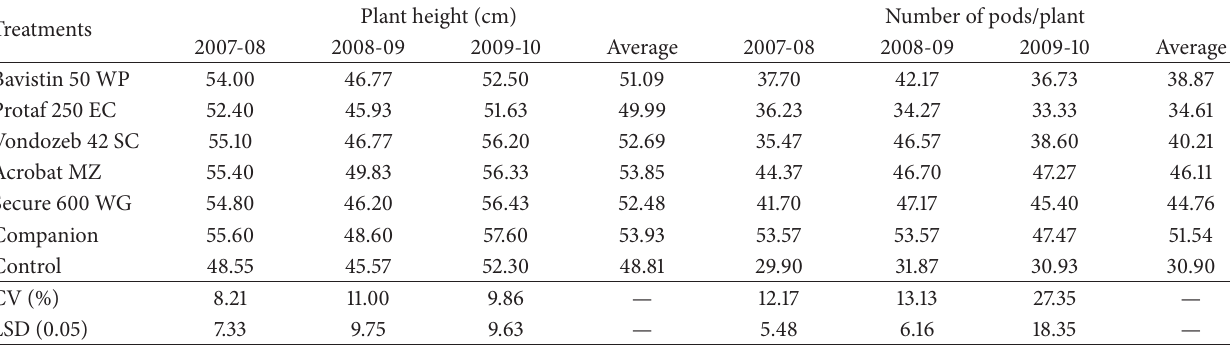
Table 2: Effect of foliar spray of fungicides with different modes of action on plant height and number of pods/plant in BGM susceptible chickpea variety “BARIchhola-1” under field conditions at Madaripur in Bangladesh during postrainy season of 2007-08, 2008-09, and 2009- 10.